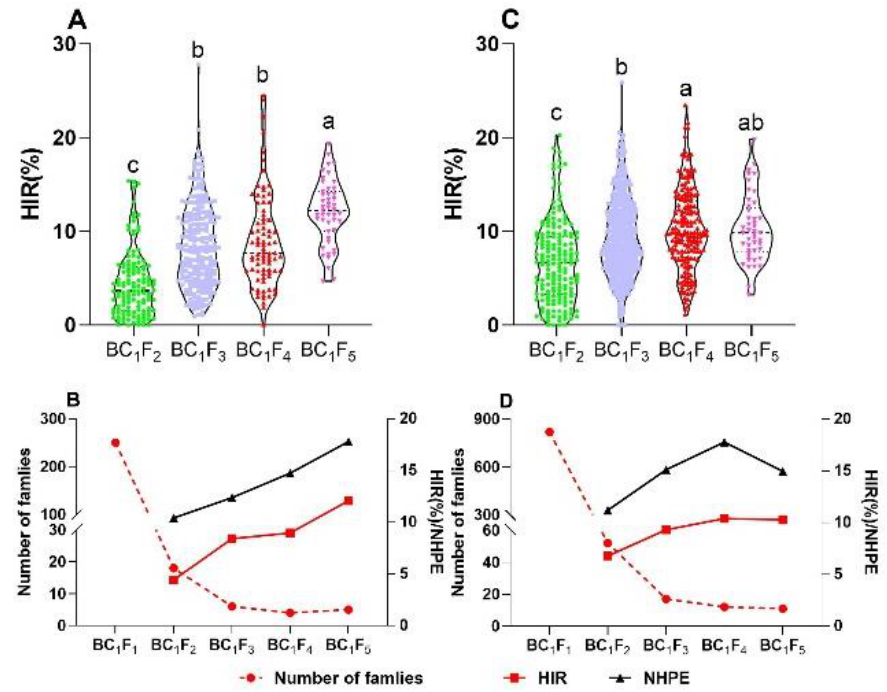
Figure 2. Selection response on the number of families, HIR, and number of haploids per ear (NHPE) for the different generations. More than three numbers of ears were used to calculate the HIR and NHPE, and a Tukey’s honestly significantly different (HSD) test was performed to identify the difference among the different selection generations. ( A ) and ( B ) correspond to the population of CAU3; ( C ) and ( D ) correspond to the population of CAU5.